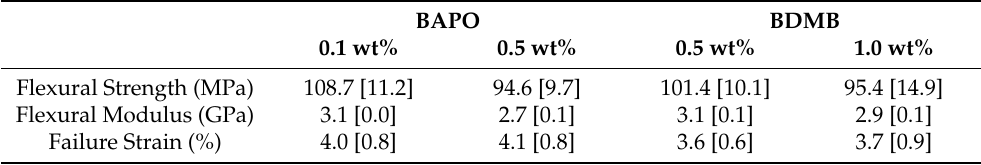
Table 1. Average flexural properties from three-point-bend testing, [x] indicates standard deviation.